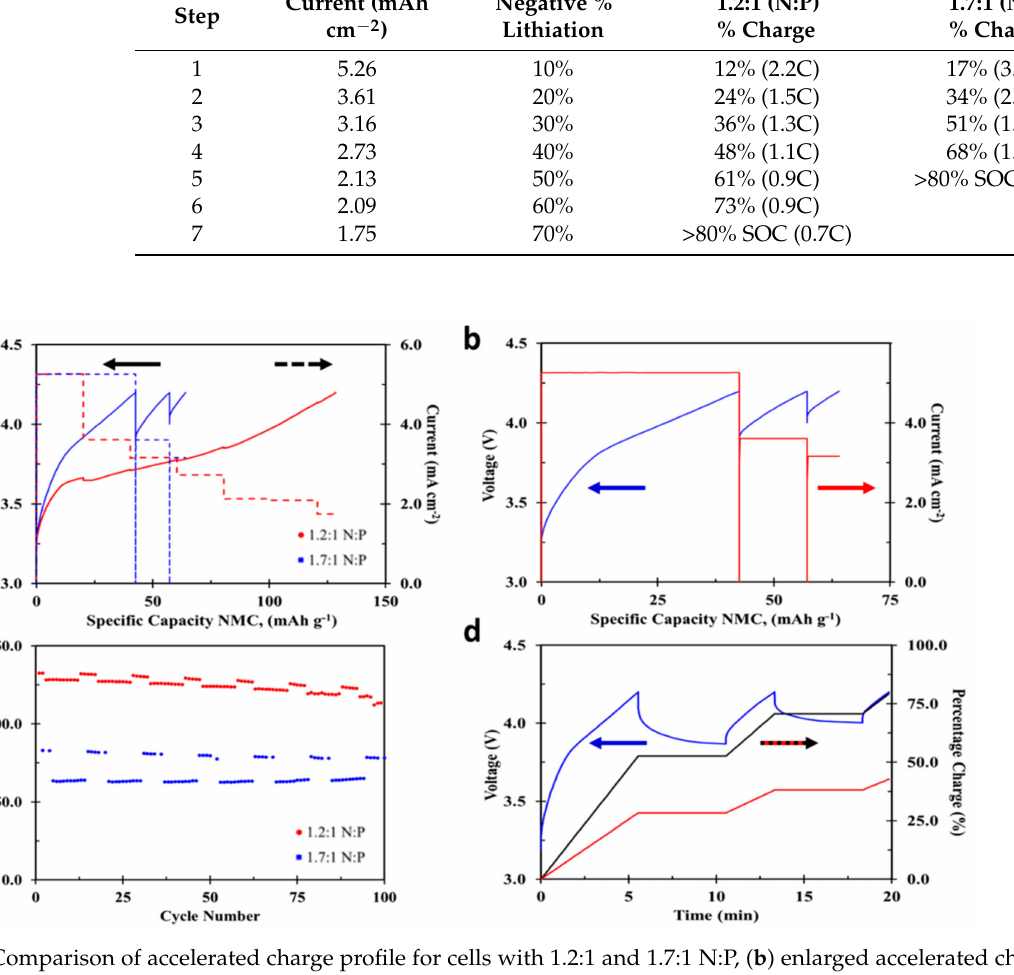
Figure 5. ( a ) Comparison of accelerated charge profile for cells with 1.2:1 and 1.7:1 N:P, ( b ) enlarged accelerated charge profile shown for cell with 1.7:1 N:P, ( c ) cycle life comparison of the first 100 cycles utilizing charge procedure, where high currents are applied based on negative electrode lithiation percentage, and ( d ) charge percentage and voltage profile for cells with 1.7:1 N:P, with percentage charge shown both based on cell reversible capacity and theoretical cell capacity based on 150 mAh g − 1